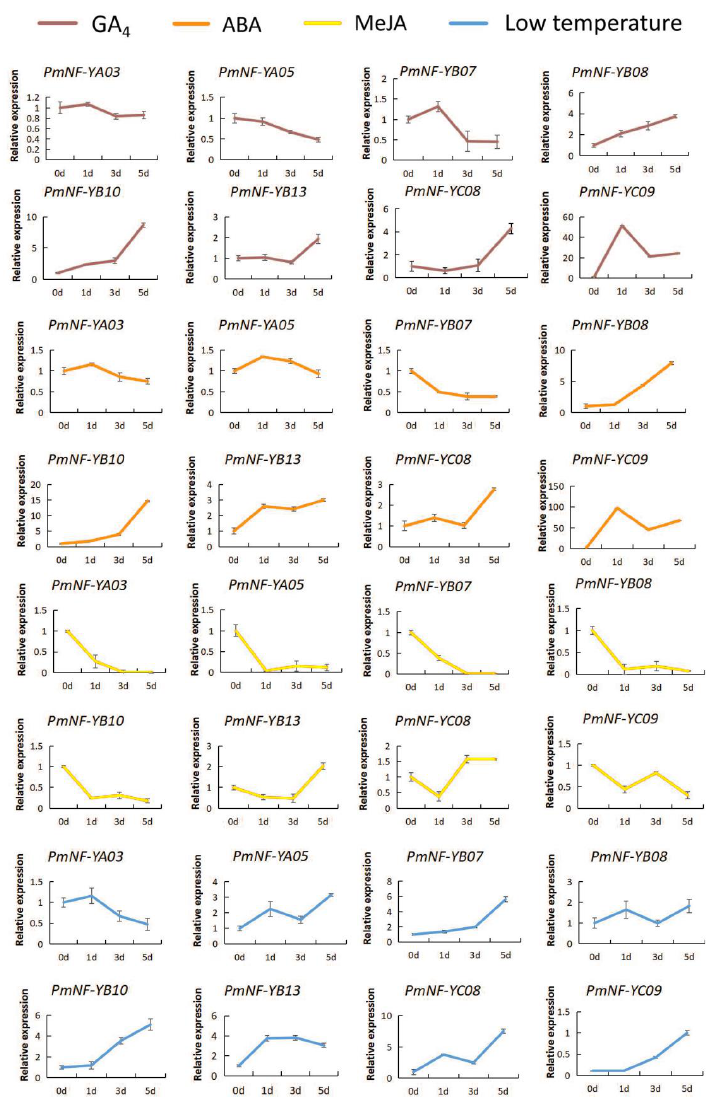
Figure 9. Expression analysis of the PmNF-Y genes in Prunus mume under GA 4 , ABA, MeJA, and low-temperature treatments.